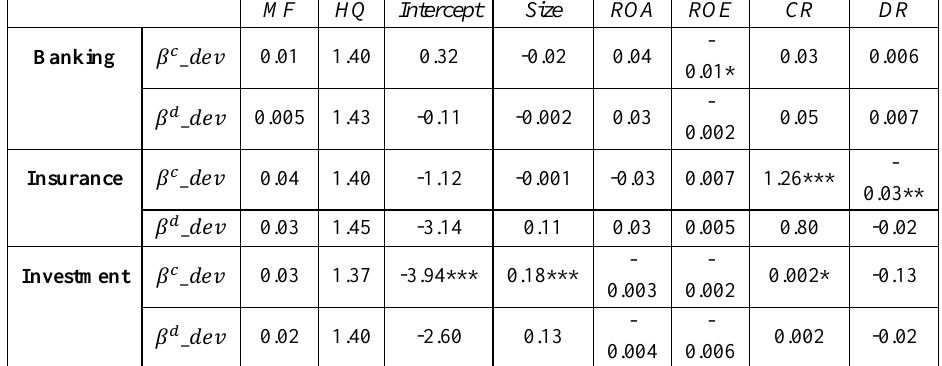
Table 8: Effect of firm characteristics on industry beta